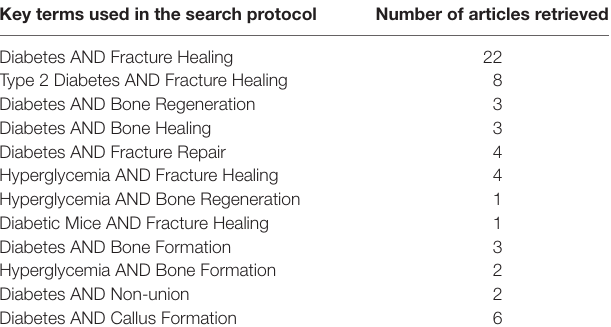
TaBle 1 | Key terms used for the literature search performed in the PubMed